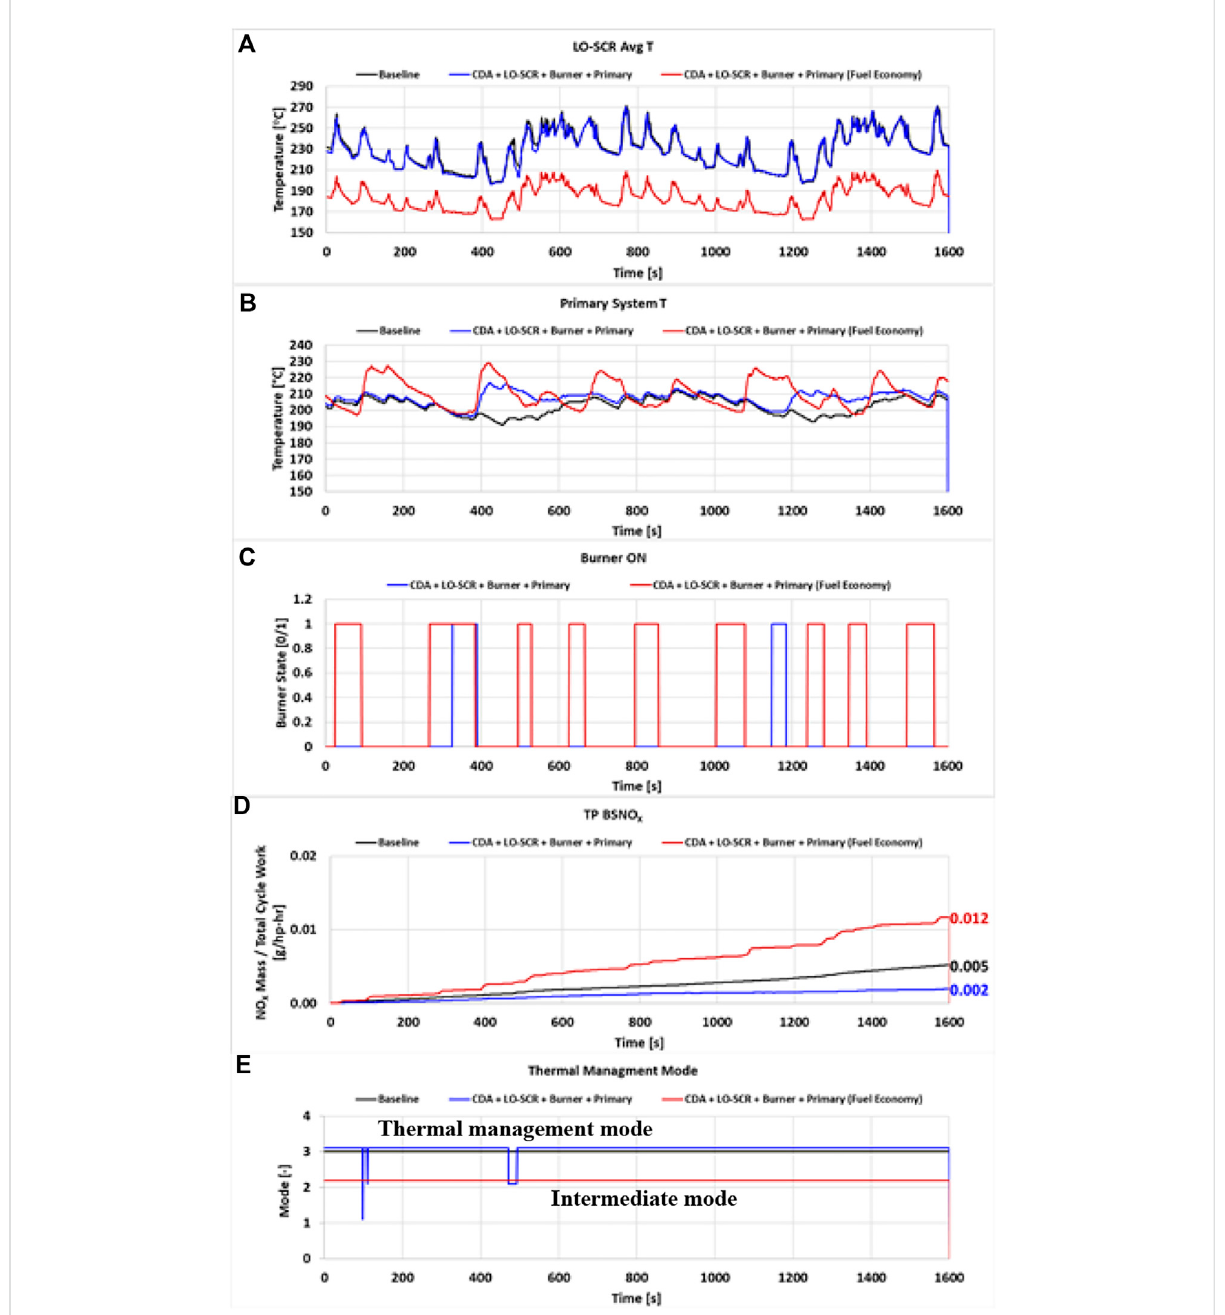
FIGURE 12 BEV measurement comparisons between Baseline and CDA + LO-SCR + Burner + Primary systems. The comparison includes an additional point with a fuel economy engine calibration. (A) LO-SCR temperature, (B) Primary system temperature, (C) Burner state, (D) Cumulative TP BSNO X , (E) Engine mode